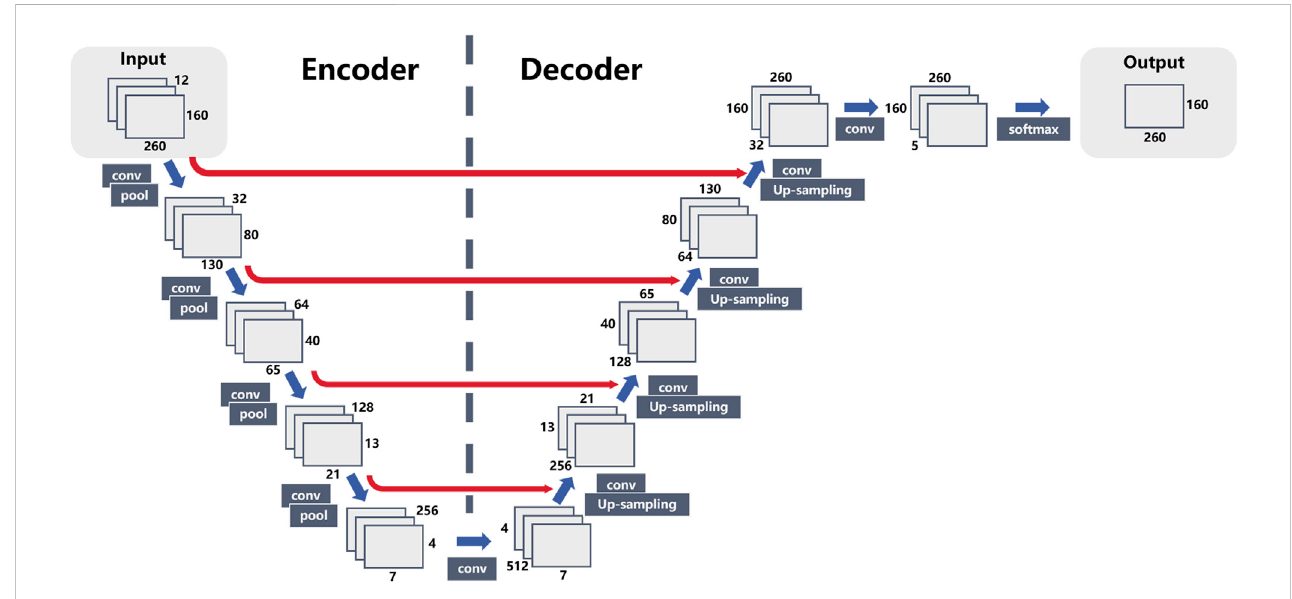
FIGURE 1 The architecture of the U-Net using in this study.